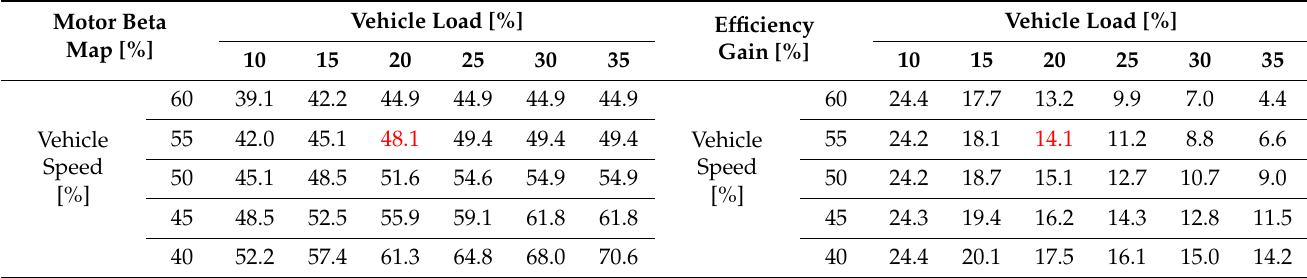
Table 4. Optimal Motor Displacement and Efficiency Gain for Expand Working Conditions (Solution A). (The number in red represents the operation point shown in the above section). Motor Beta